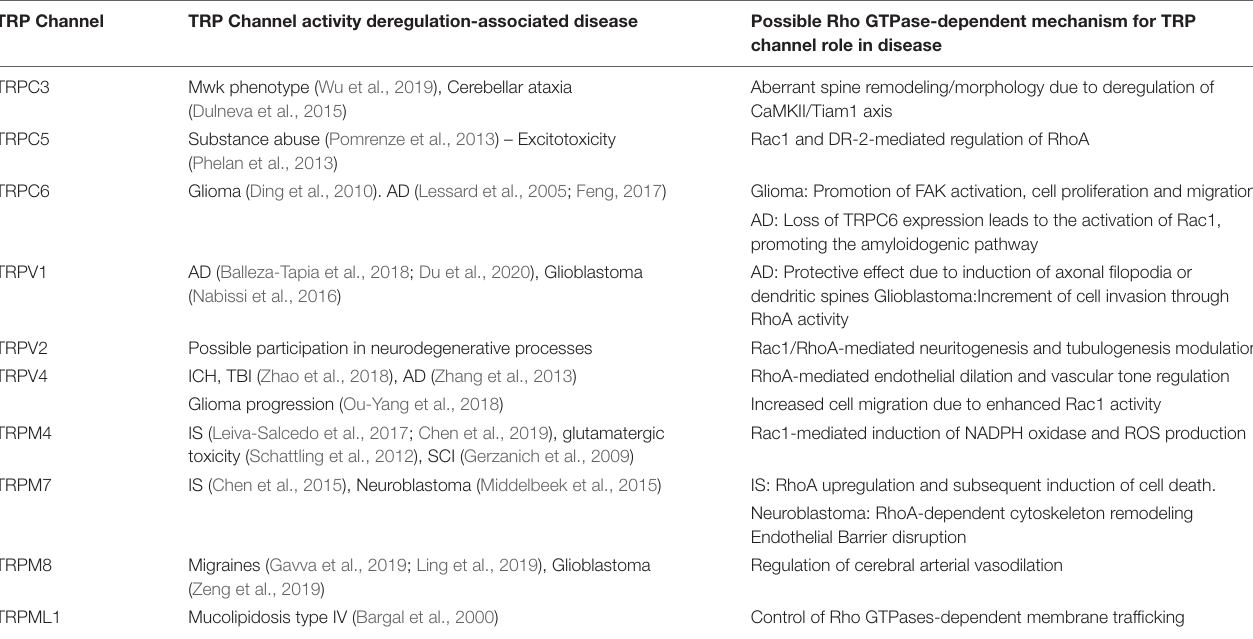
TABLE 2 | TRP channels-associated pathologies and possible Rho GTPases-dependent mechanisms. TRP